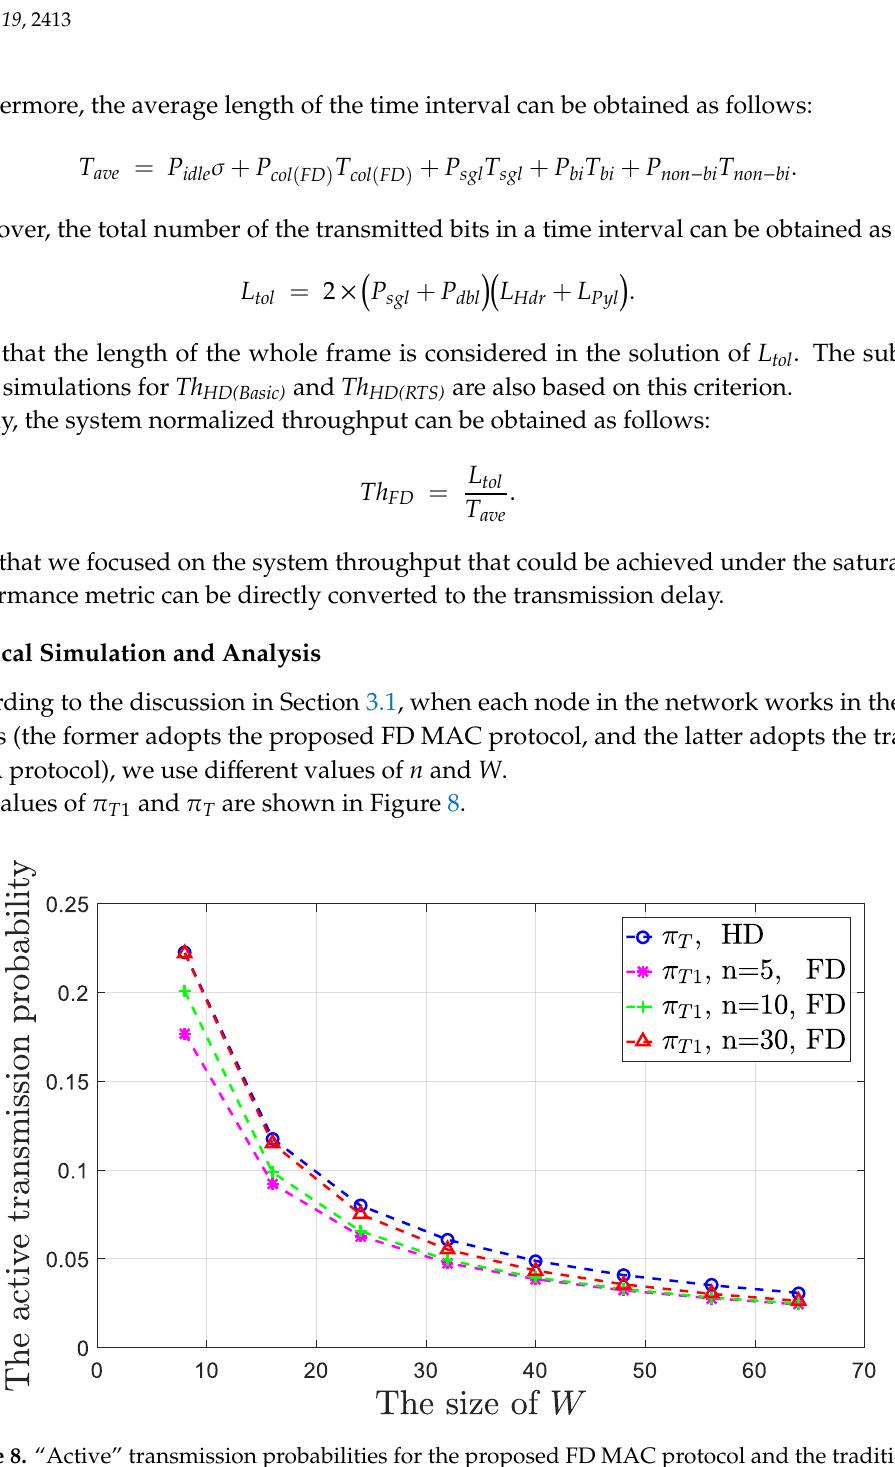
Figure 8. “Active” transmission probabilities for the proposed FD MAC protocol and the traditional CSMA/CA protocol versus the different values of n and W .